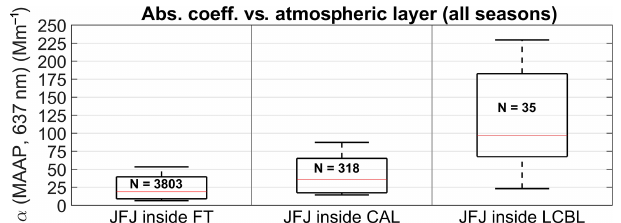
Figure 9. Box plot of α and FT, CAL and LCBL pairs. Each portion collects all pairs over the corresponding atmospheric region for all seasons. The boxes show the median (within the box), the interquar- tile range (upper and lower box boundaries) and the 15.87–84.13 percentile range of α values